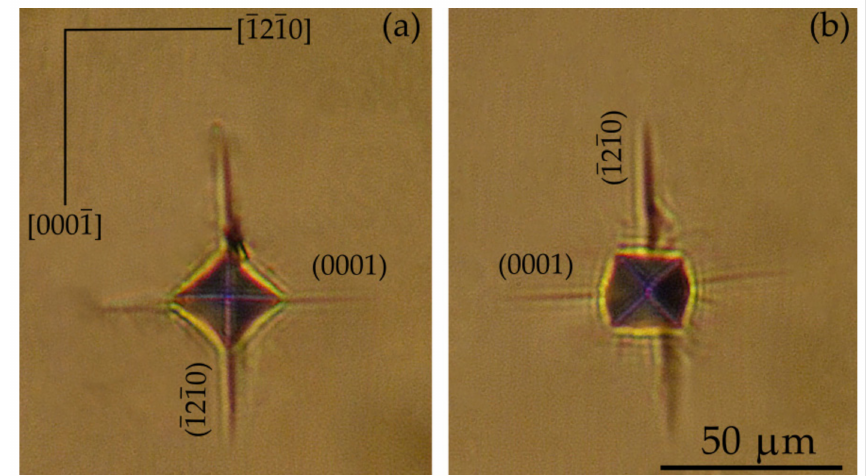
Figure 7. The Vickers indentation patterns of the ( 1010 ) planes of CeF 3 crystal at different indenter orientations (the indenter diagonals coincide with the [0001] and [ 1210 ] directions ( a ) and rotated by 45 ◦ relative to the [ 1210 ] direction ( b )) under the load P = 100 gf. Crystallographic planes corresponding to cracks are